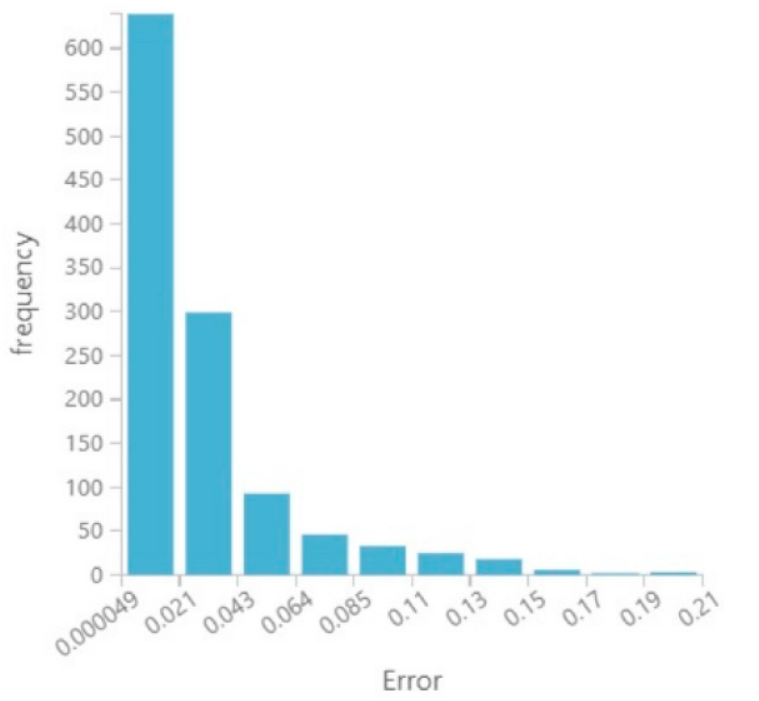
Figure 5. Error histogram of the predicted values of the dc / dt by using all the features included in the pilot plant dataset.